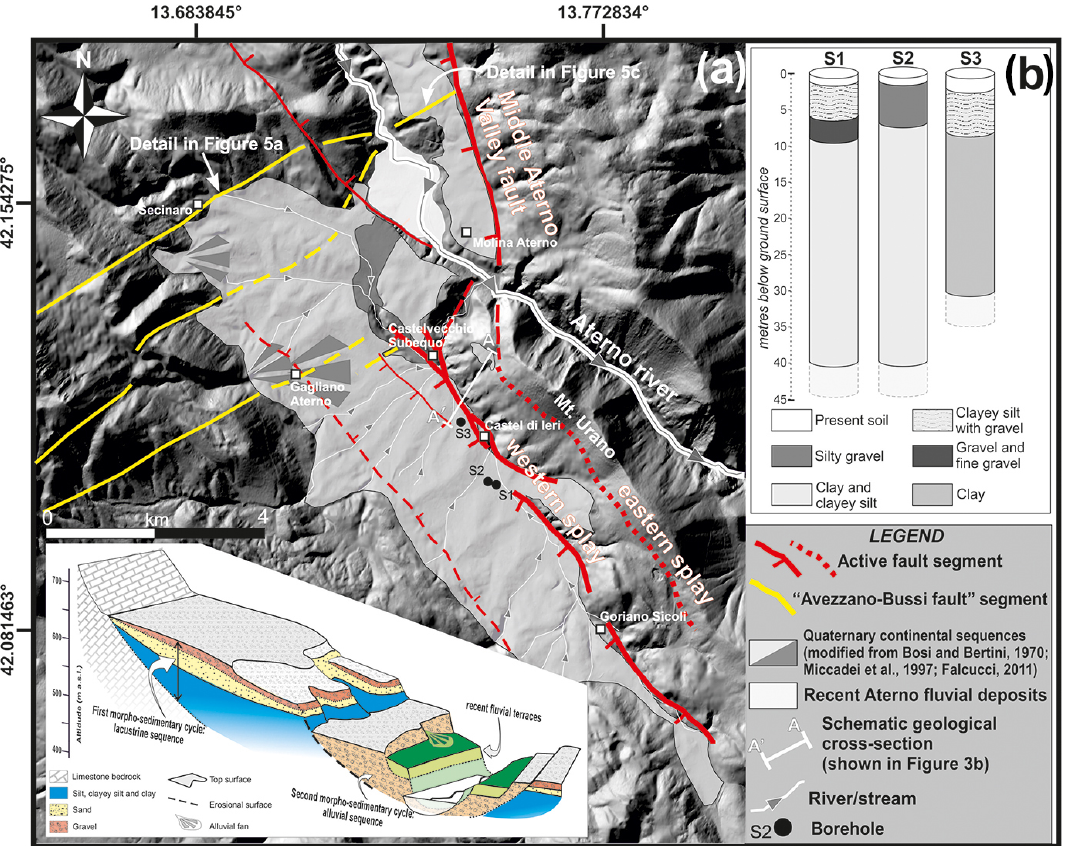
Figure 2. (a) Shaded relief of the Subequana Valley (plan view) on which simplified geological map (modified after Bosi and Bertini, 1970; Miccadei, 1997; Falcucci, 2011) is reported; morpho-stratigraphic reconstruction of the Quaternary succession of the Subequana Valley (Falcucci et al., 2011), inset. (b) Stratigraphy of boreholes drilled in the Subequana Valley during the